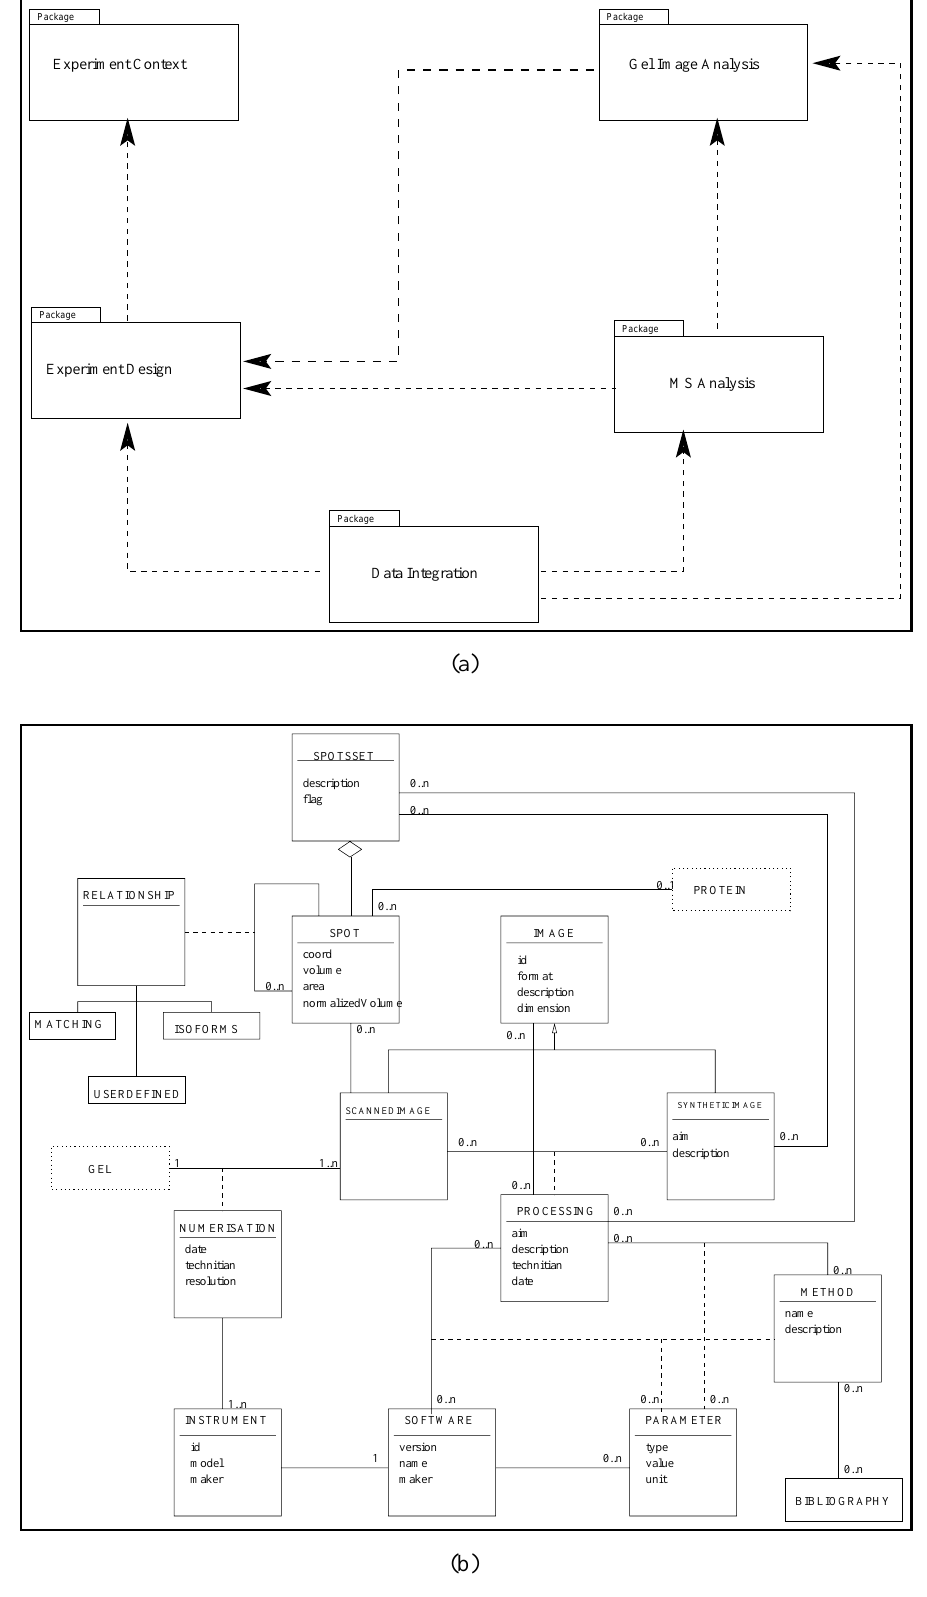
Figure 5: A partial view of the conceptual data model implemented in PARIS. The model is repre- sented with the industry-standard UML conventions (a) the package diagram. The system PARIS encompasses five packages, and each package describes a set of closely related information. (b) A detailed description of the gel image analysis